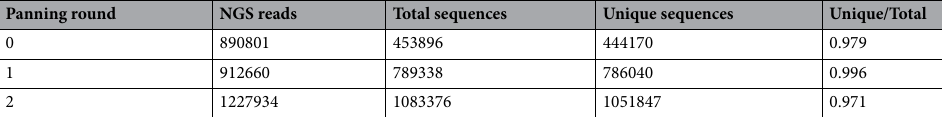
Table 2. Summary of NGS data. VH genes of panning samples were analyzed by Miseq. Raw sequence reads were obtained (NGS reads). Correct sequences with antibody structure were extracted using BLAST based software (Total sequences).